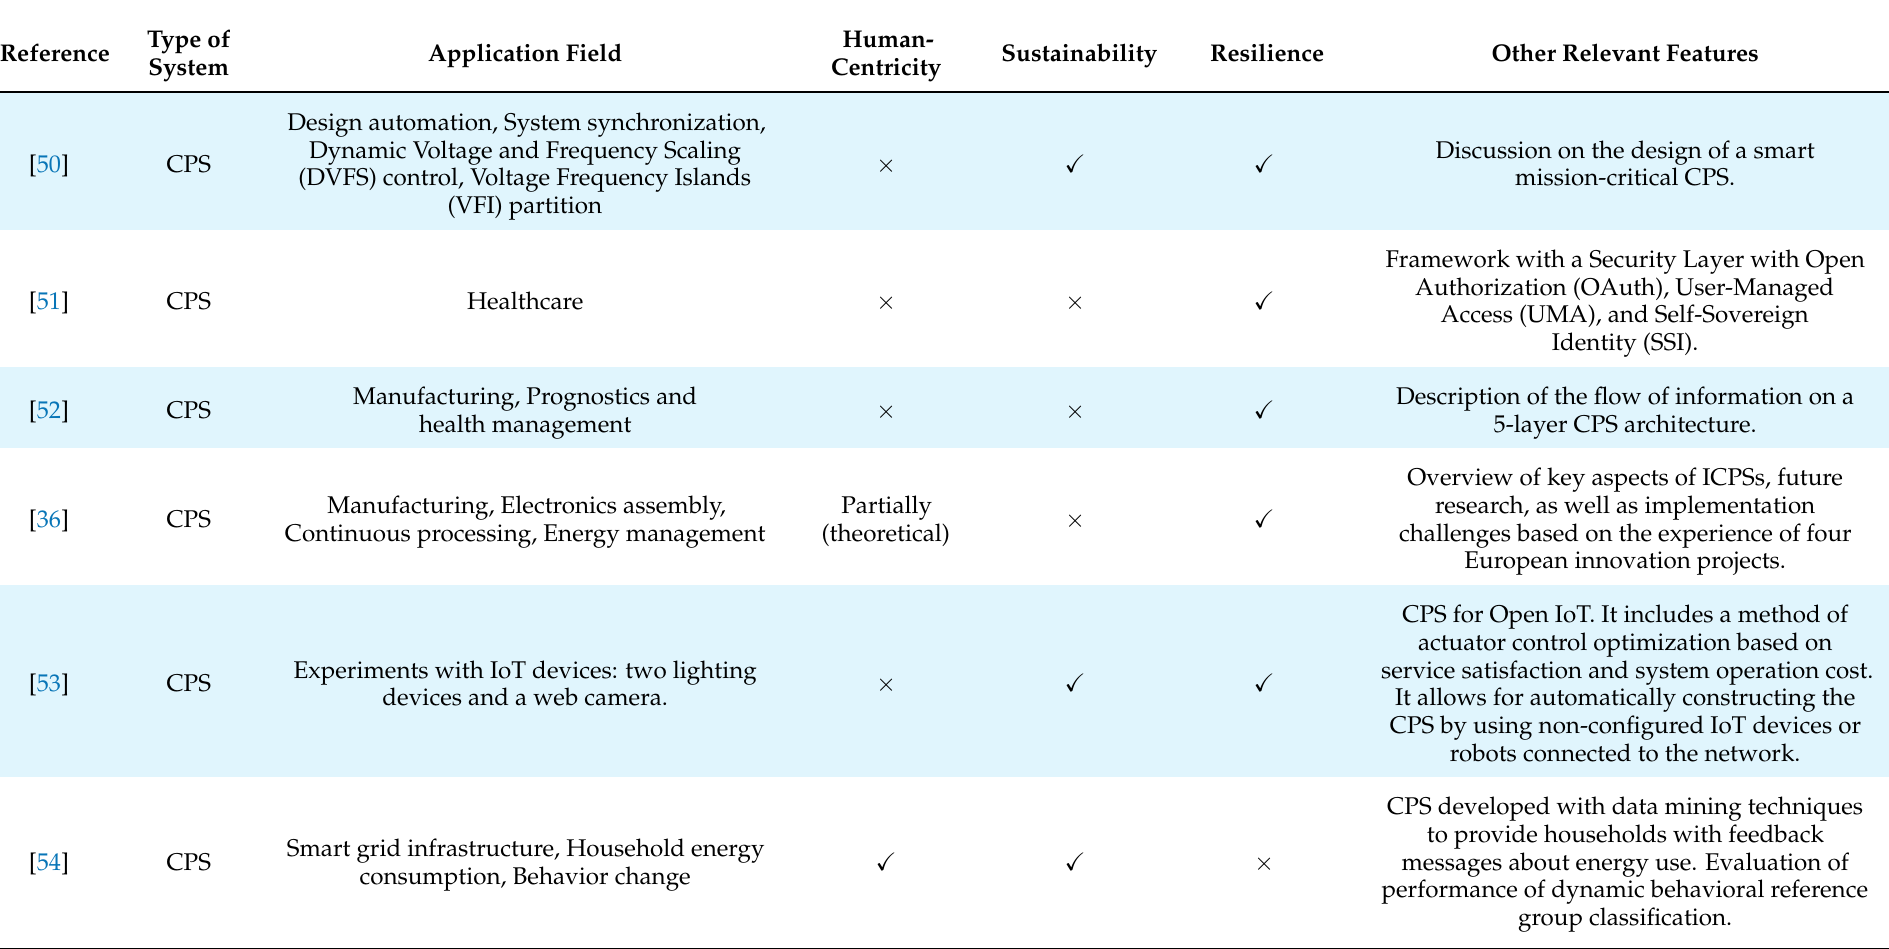
Table 1. Main characteristics of the most relevant